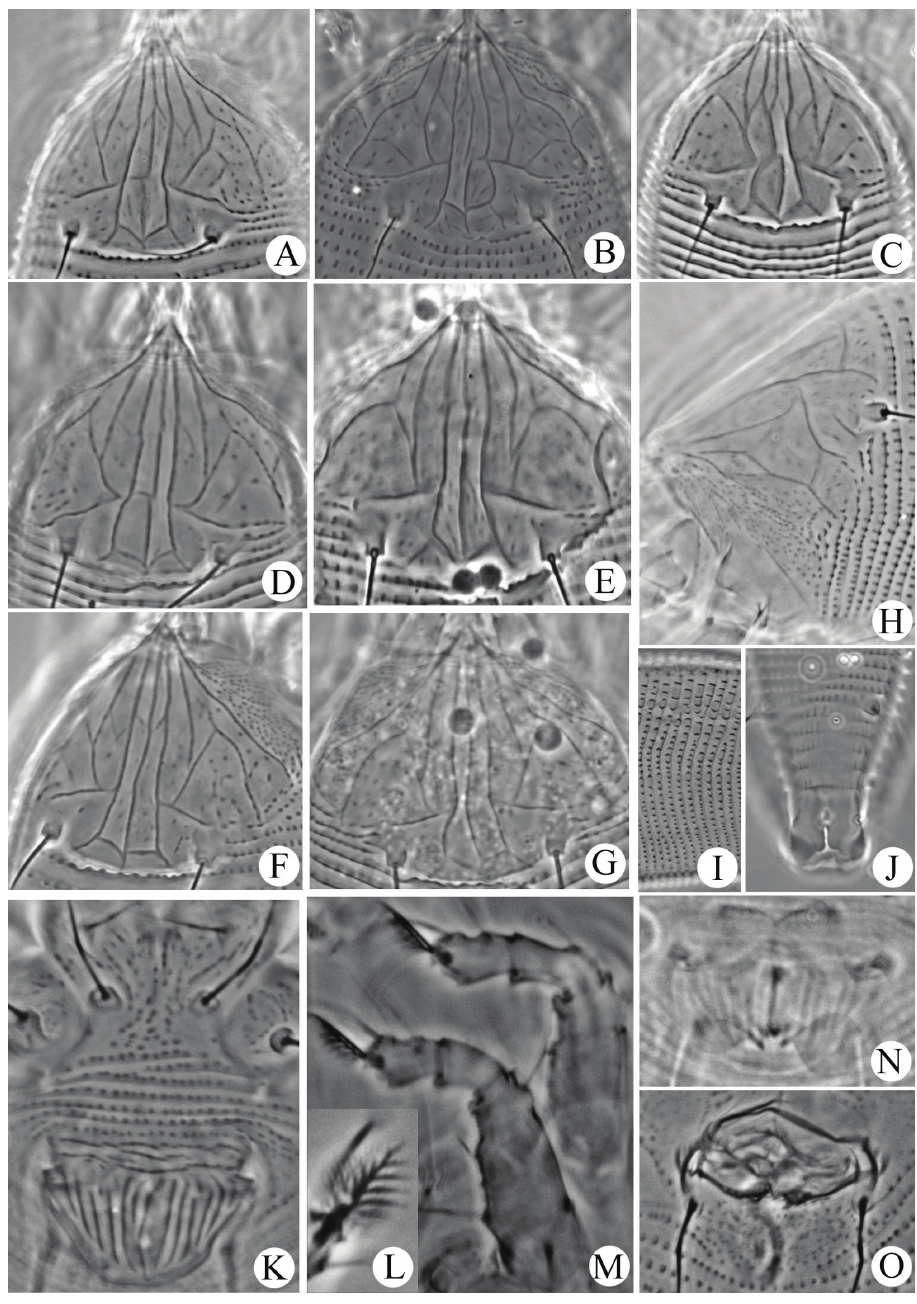
Figure 3. Micrographs of Aculops jilinensis sp. n.: A–G prodorsal shield H lateral view of anterior body region I lateral view of annuli at mid-region of opisthosoma J ventral view of posteriormost region of opisthosoma K female coxigenital region L empodium M legs I (right) and II (left) N female internal genitalia O male genital